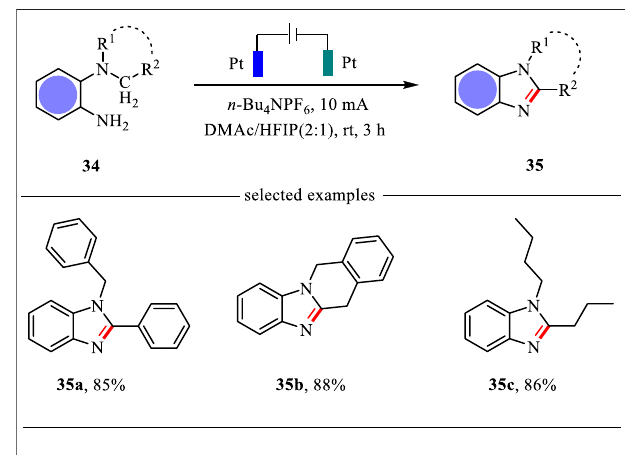
SCHEME 13 | The electrochemical synthesis of